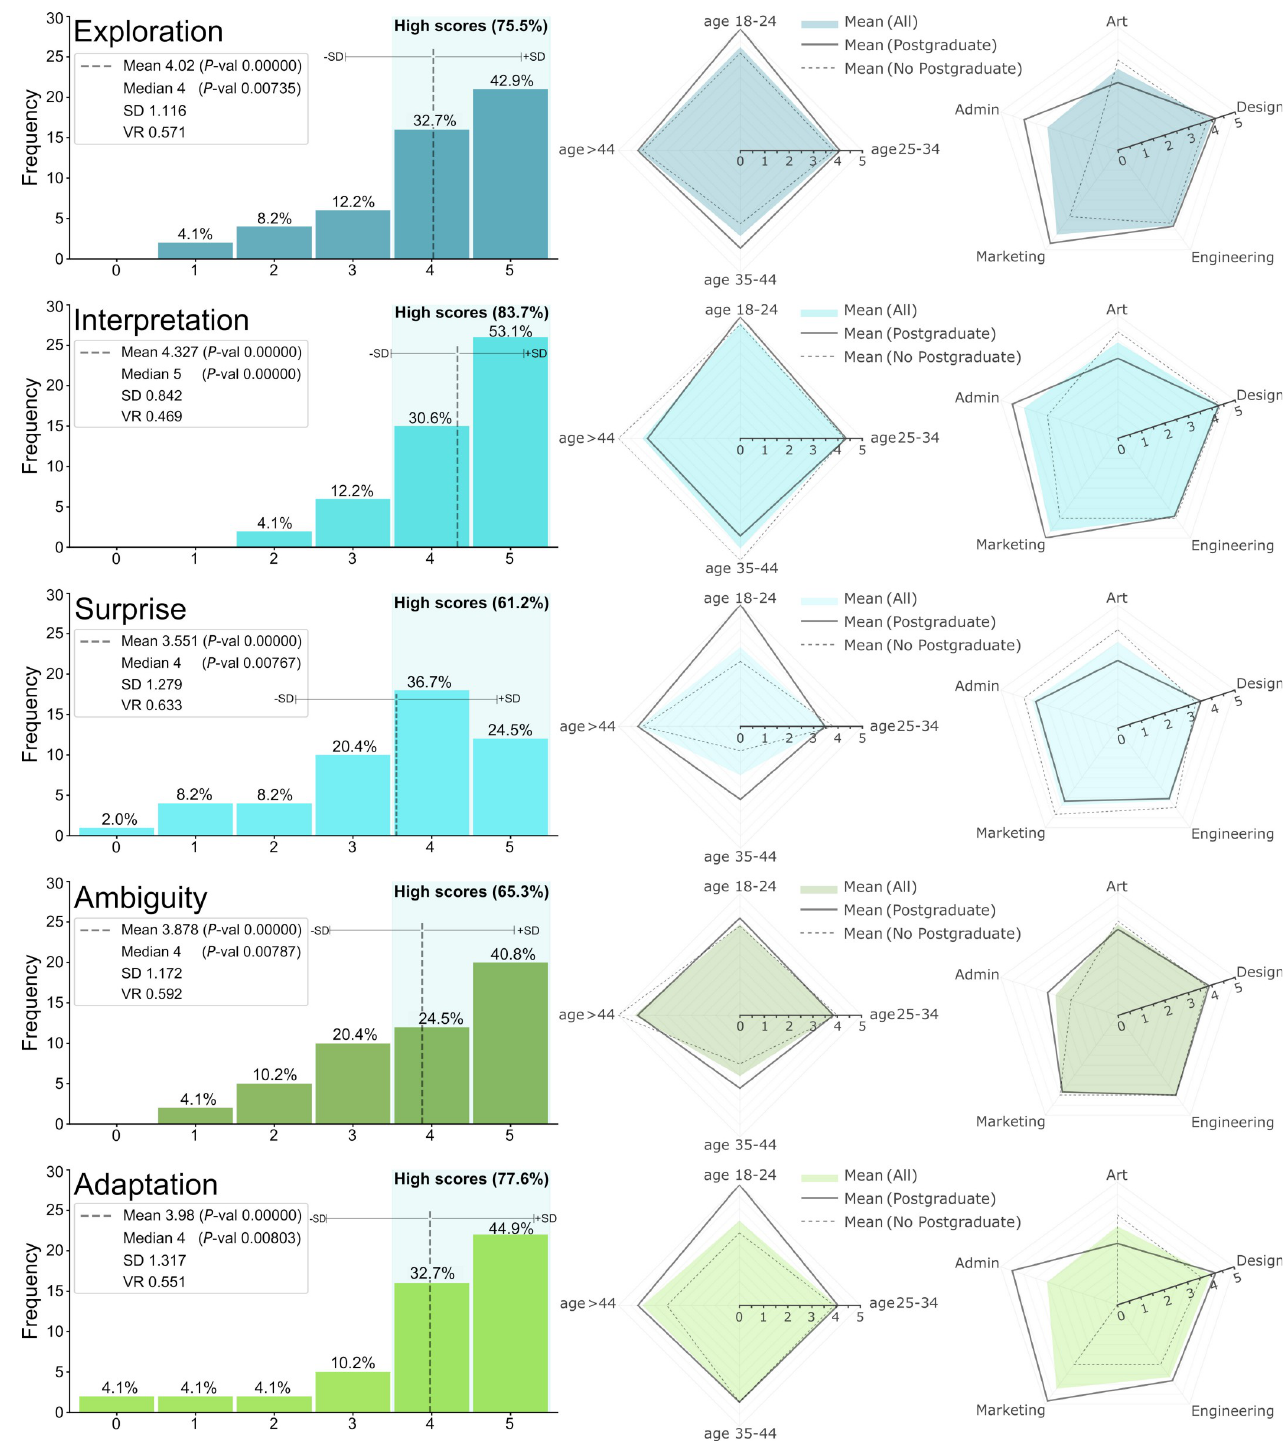
Fig 20. Survey results of perceptions about Shapi’s capabilities and potential value with 0–5 scores. Results are displayed by frequency, age group, occupation, and Postgraduate studies. Metrics include mean, median, Standard Deviation, Variation Ratio, and P -value.